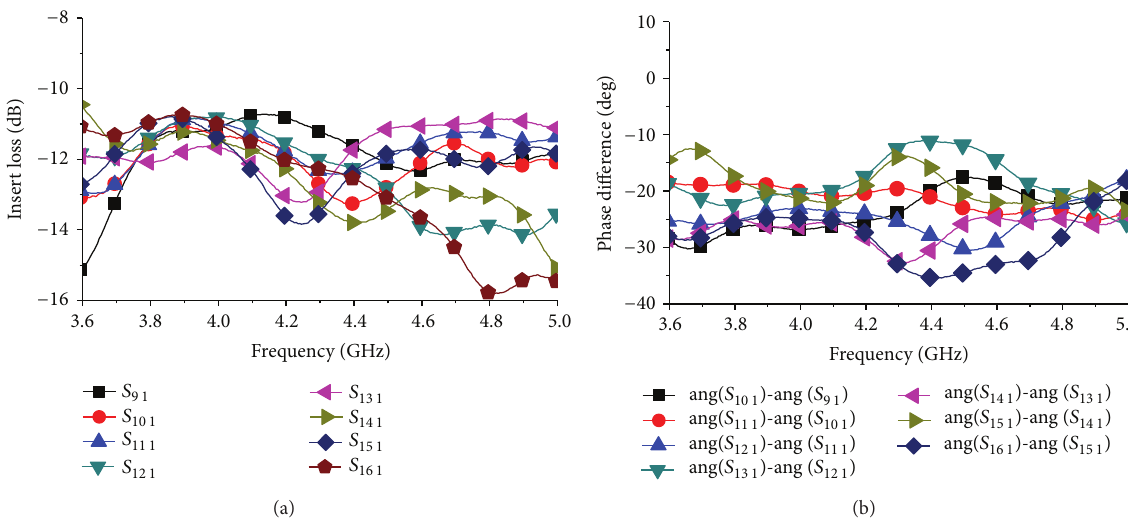
Figure 9: The measured results of insertion loss (a) and phase difference (b) at Port 1. The phase difference at Port 1 is − 22.5 ∘ theoretically.